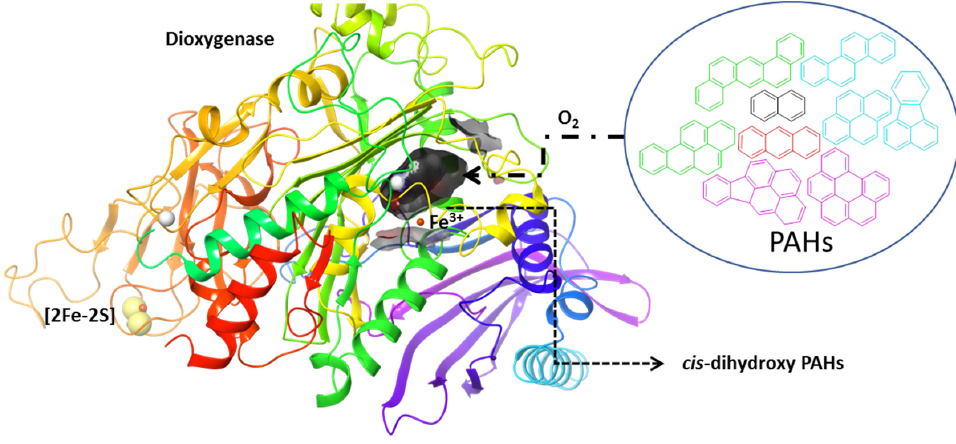
Figure 1. Schematic presentation of dioxygenase from Rhodococcus jostii RHA1 (Protein Data Bank ID 1ulj). PAHs and oxygen molecule are substrates in binding sites of dioxygenase (Fe 3+ ) to produce cis-hydroxylated